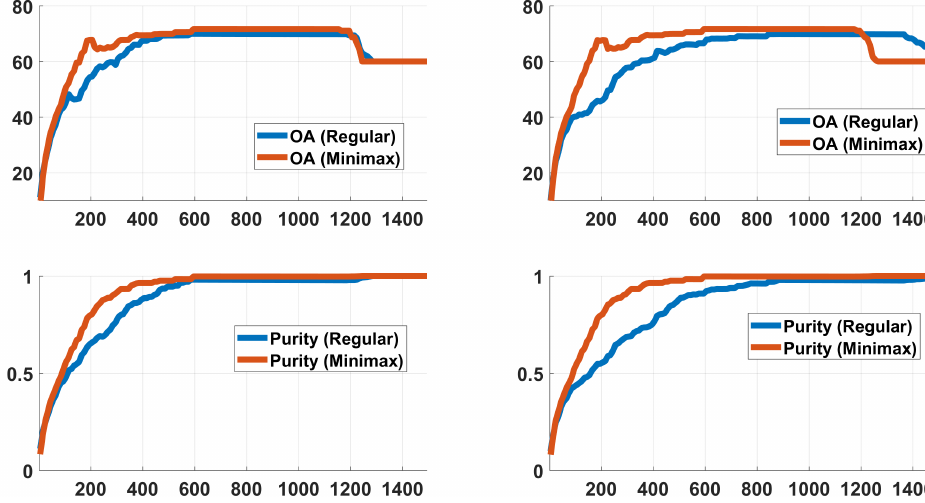
Figure 1. Clustering results on the Pavia University scene with KNNCLUST (left column) and GWENN (right column) as a function of k , the number of nearest neighbours. Top : overall accuracy, bottom : cluster